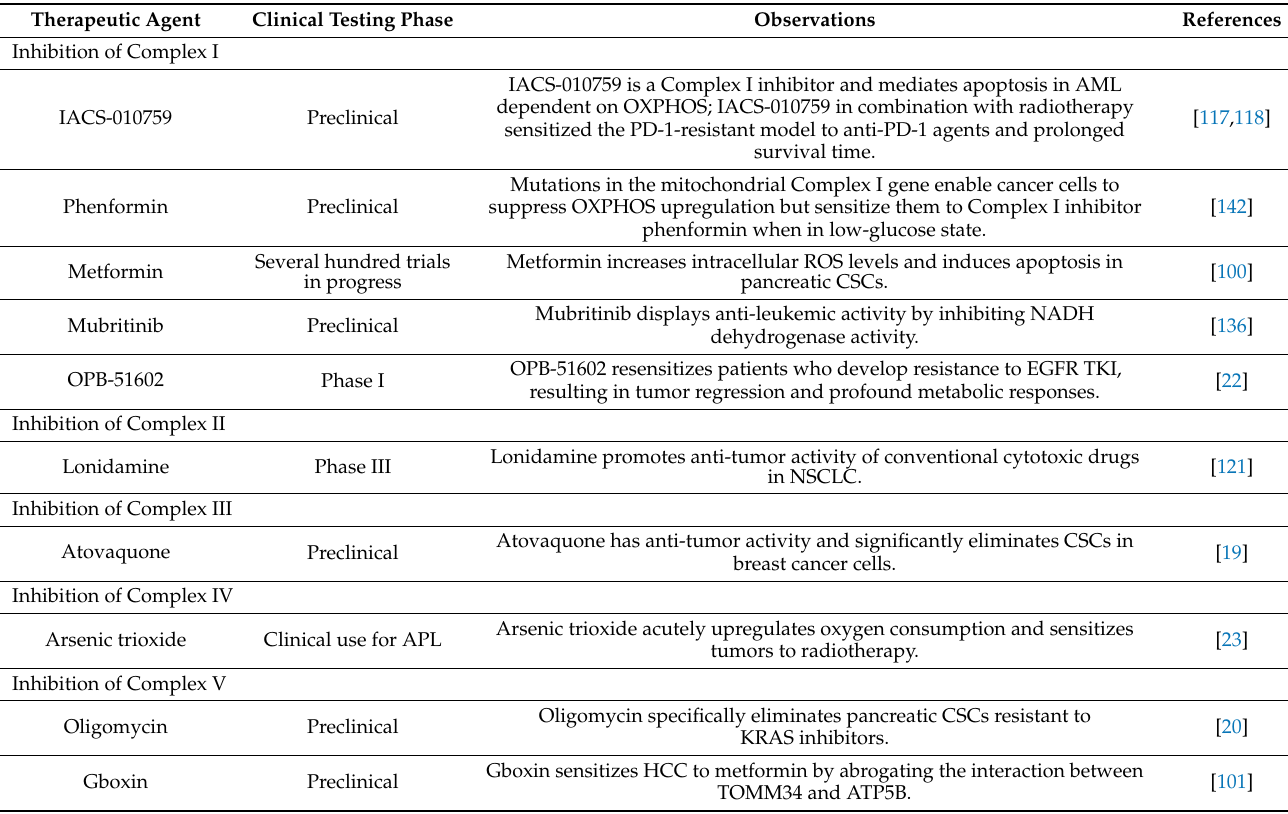
Table 1. A list of drugs related to OXPHOS systems for cancer